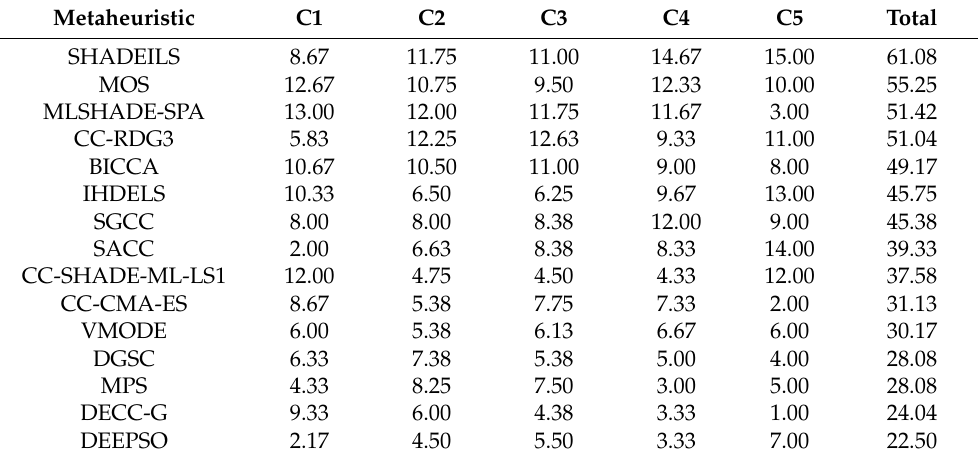
Table 11. The ranking of state-of-the-art metaheuristics.